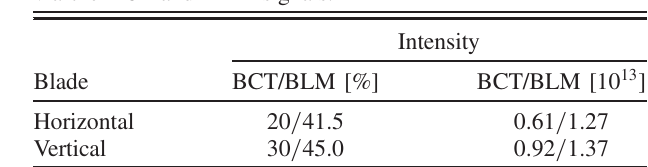
TABLE VI. Summary of amount of beam scraped as estimated via the BCT and BLM signals.